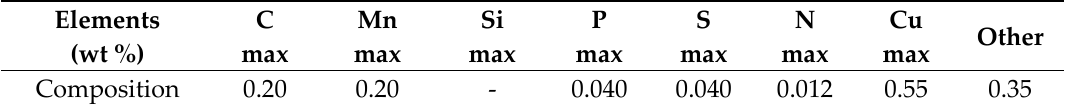
Table 1. Chemical composition of carbon steel substrates.